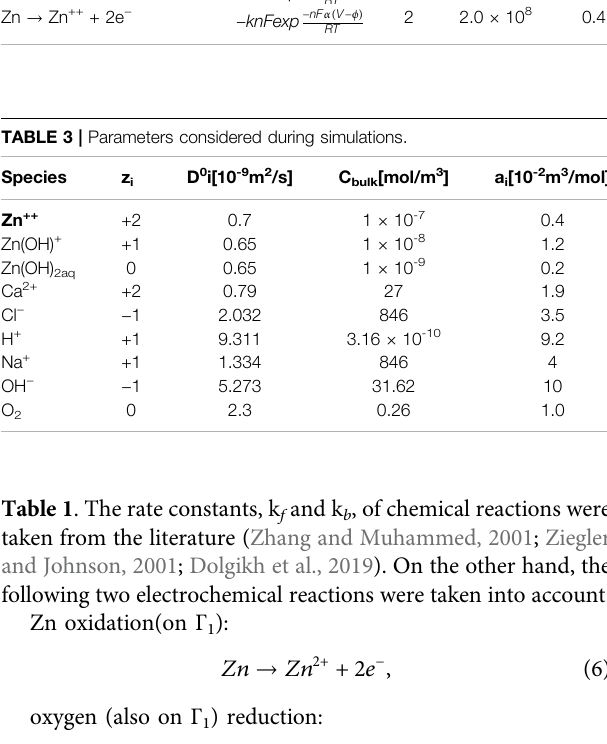
TABLE 2 | Electrochemical reactions and kinetic constants (Simillion et al., 2016). Reaction